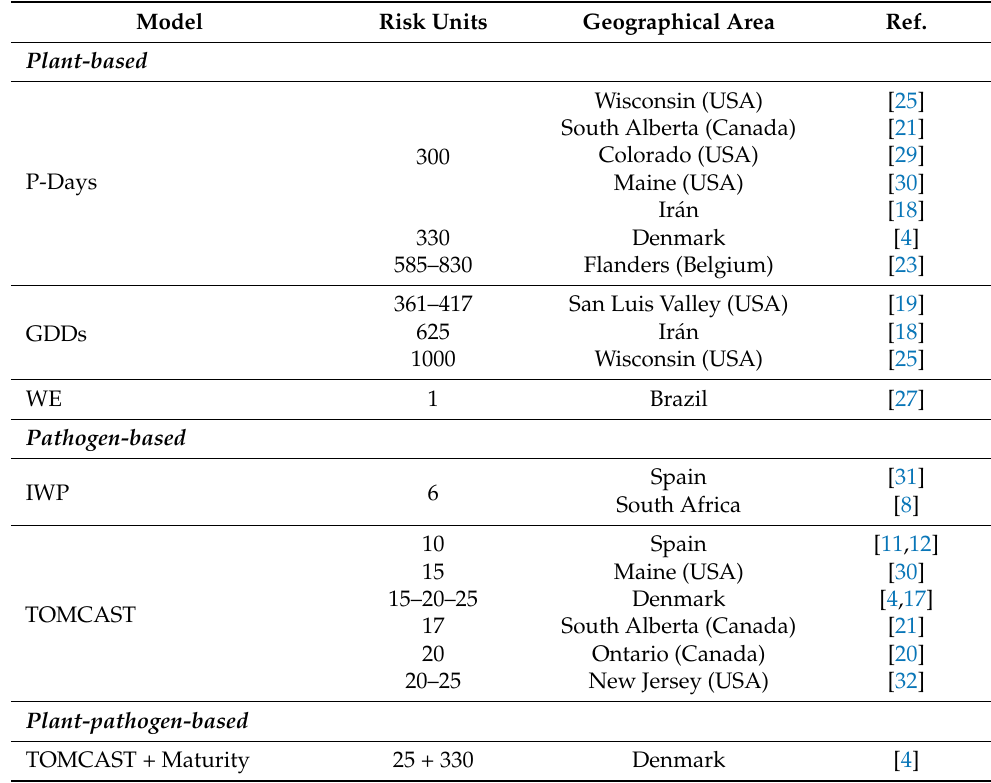
Table 2. Forecasting models for potato early blight and risk units established by authors in different geographical areas. P-days: Physiological Days; GDD: Growing Degree Days; WE: Wang Engel; IWP: Interrupted Wetting